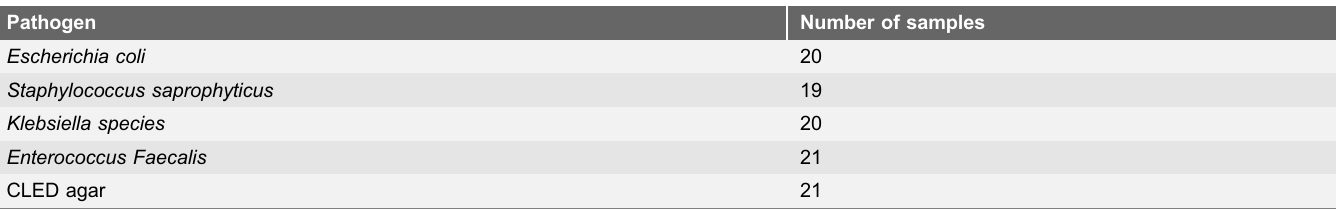
Table 1. Description of bacterial culture